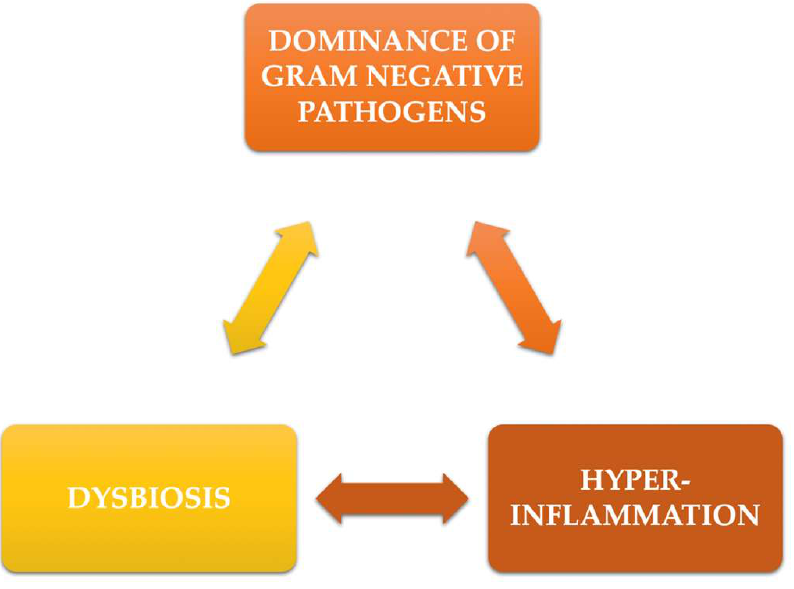
Figure 1. The vicious circle in periodontitis inflammation.